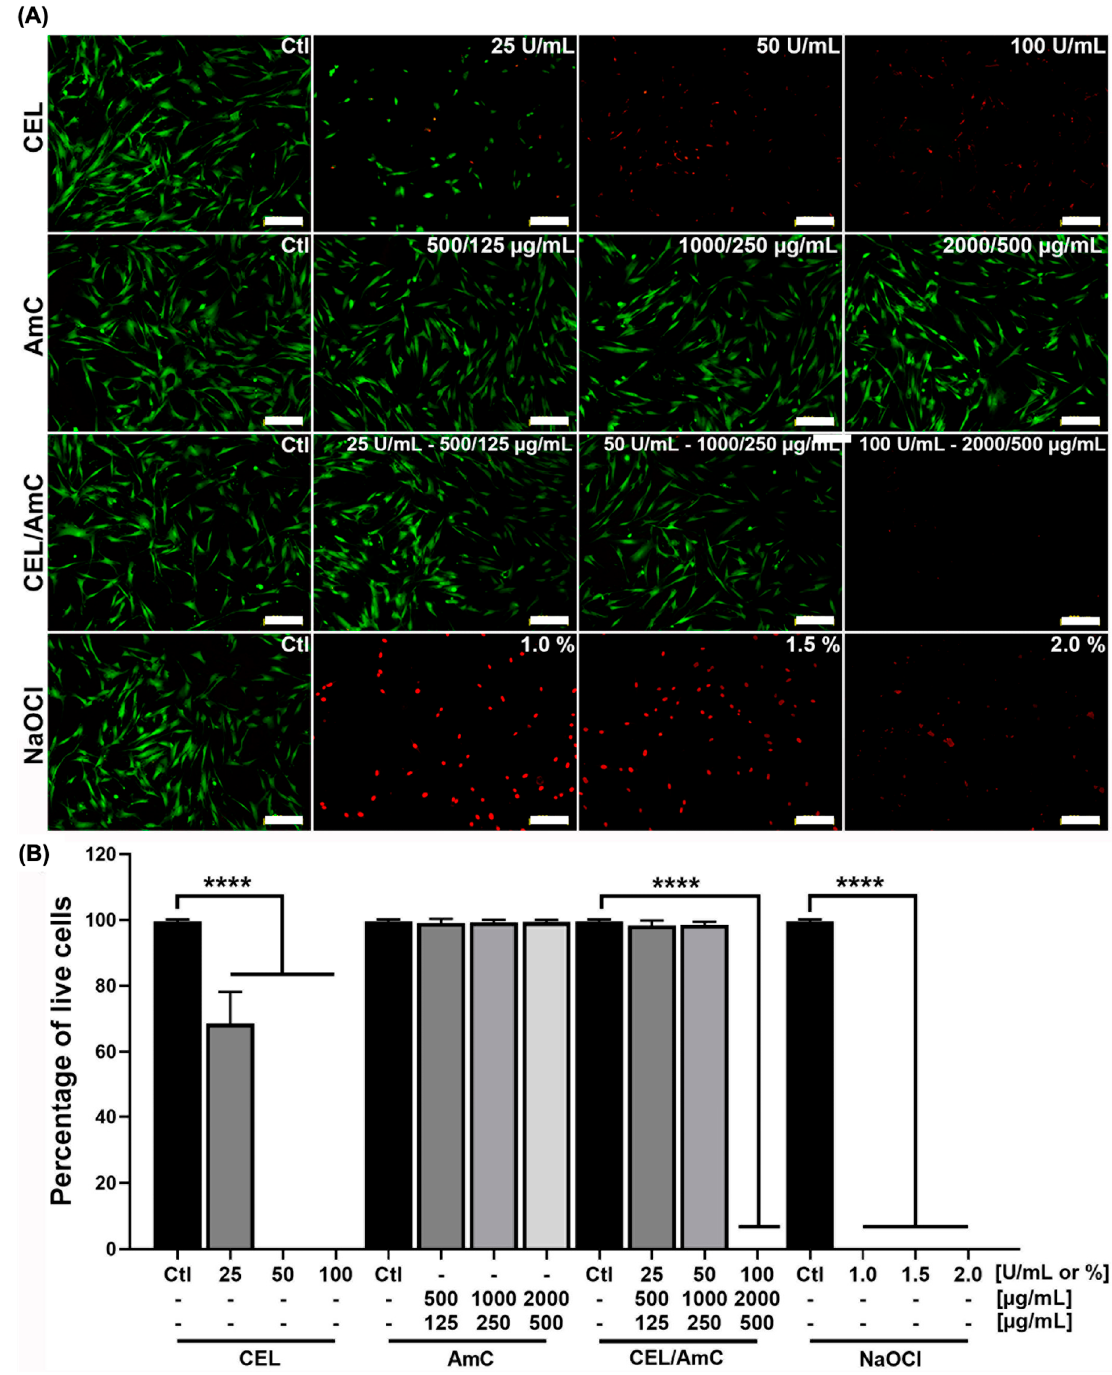
Figure 4. Viability of dermal fibroblasts. ( A ) Cells were exposed to different treatments and incu- bated with calcein (positive in green) and ethidium bromide (dead in red). ( B ) Viability results are expressed as a percentage of live cells compared with the control group (PBS). CEL, cellulase; AmC, amoxicillin/clavulanic acid; CEL-AmC; cellulase combined with amoxicillin/clavulanic acid; NaOCl, sodium hypochlorite. ANOVA was performed with Dunnett’s post hoc test. **** p -value < 0.00001. Scale bars = 200 μ m.